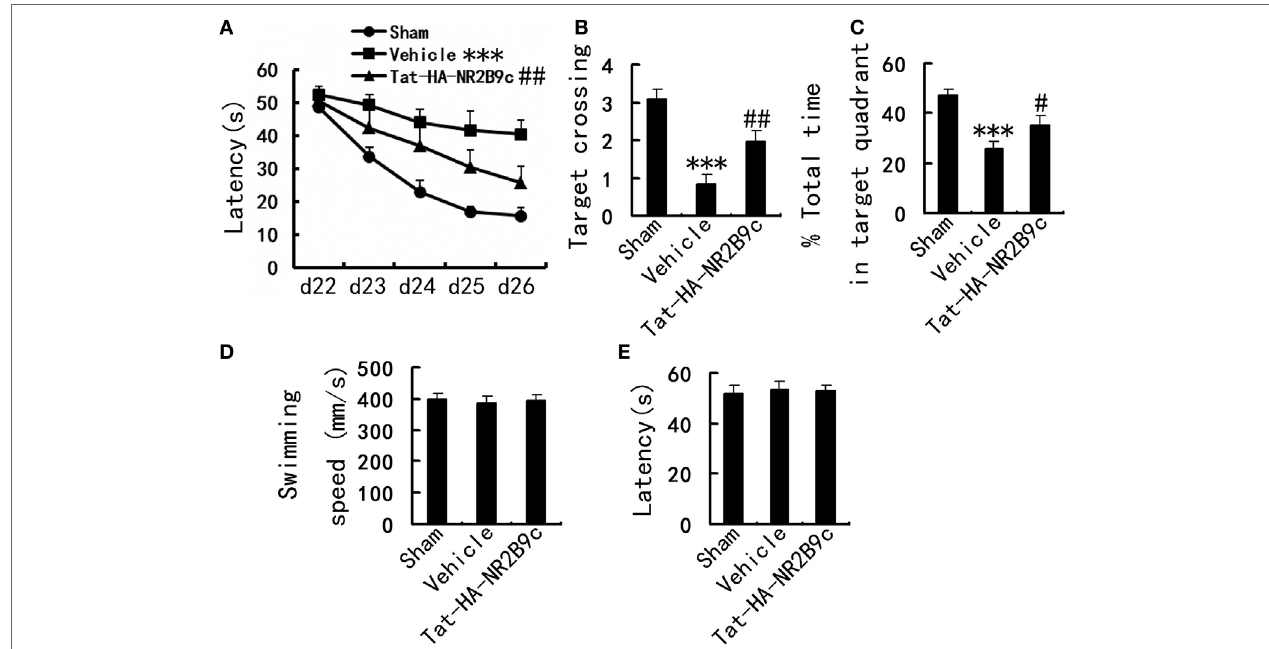
FigUre 1 | Effects of Tat-HA-NR2B9c on transient global ischemia (TGI)-induced spatial learning and memory deficits in rats as measured by Morris water maze. (a) Escape latency measured during days 22–26. (B) Target crossings; (c) time spent in target quadrant measured at day 27 after TGI in Morris water maze task. (D) Swimming speed; (e) the latency to reach platform in visible platform trials measured at day 21 after TGI ( n = 10 for sham; n = 11 for vehicle, and Tat-HA- NR2B9c). Data are mean ± SEM (*** P < 0.001 vs sham; # P < 0.05, ## P < 0.01 vs